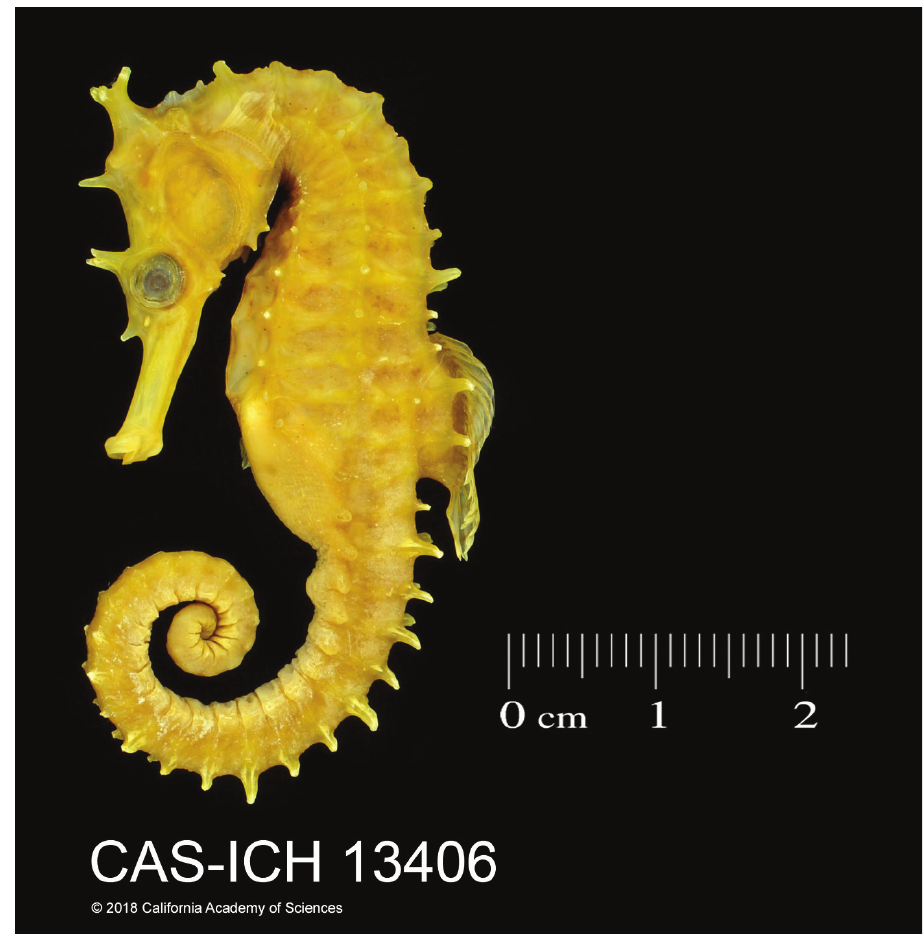
Figure 10. Hippocampus procerus , CAS-ICH 13406, adult male, non-type, 113.4 mm SL, Mackay, Queensland, Australia (photograph Jon